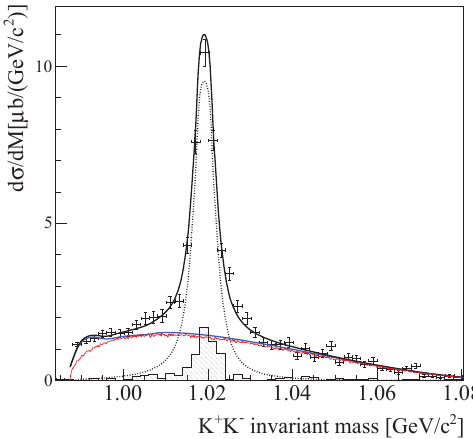
Fig. 1. (Color on-line) The pp → ppK + K − differential cross section in terms of the K + K − invariant mass. The solid line is the sum of φ (dotted line) and non- φ contributions (the red curve is phase space and the blue a parametrization based upon two-body final state interactions, cf. [3]). The error bars correspond only to the statistical uncertainties; systematic uncertainties are shown by the hatched histograms.